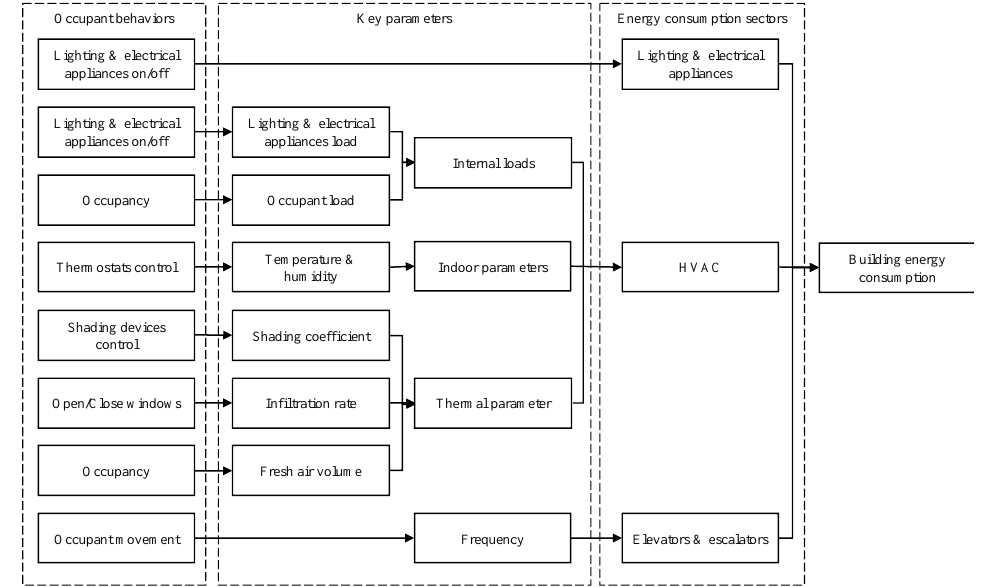
Figure 1. Influences of occupant behaviors on building energy consumption. To gain insight into the relationship between occupant behaviors and building en- ergy consumption, the International Energy Agency (IEA) established Annex 66 [4] and Annex 79 [5] to develop occupant behavior models and apply them to building design and control. Various static models, stochastic models and machine learning models have been used to simulate the presence of occupants and other behaviors, which are summa- rized in Table 1. Table 1. Summary of occupant behavior models.